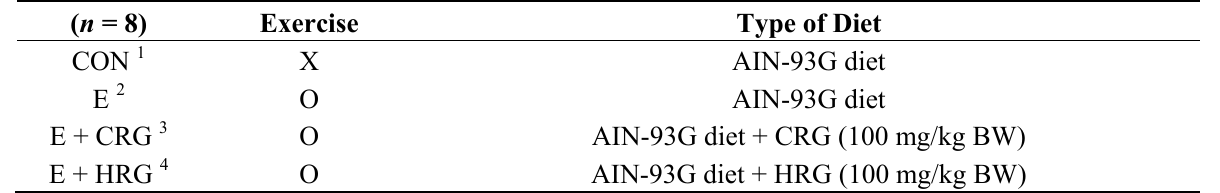
Table 1. Experimental design.